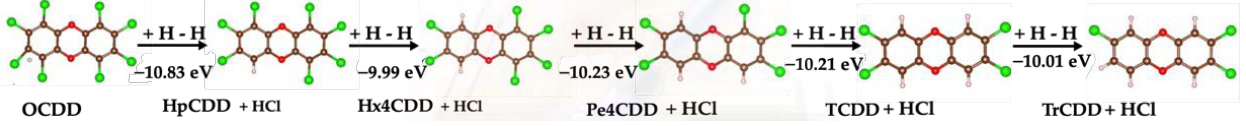
Figure 7. Full consecutive dehydrogenation of the set of PCDDs, from the octachlorodibenzodioxin molecule to trichlorodibenzodioxin. The brown spheres represent C atoms, the green spheres represent Cl atoms, the red spheres represent O atoms and white spheres are H atoms .